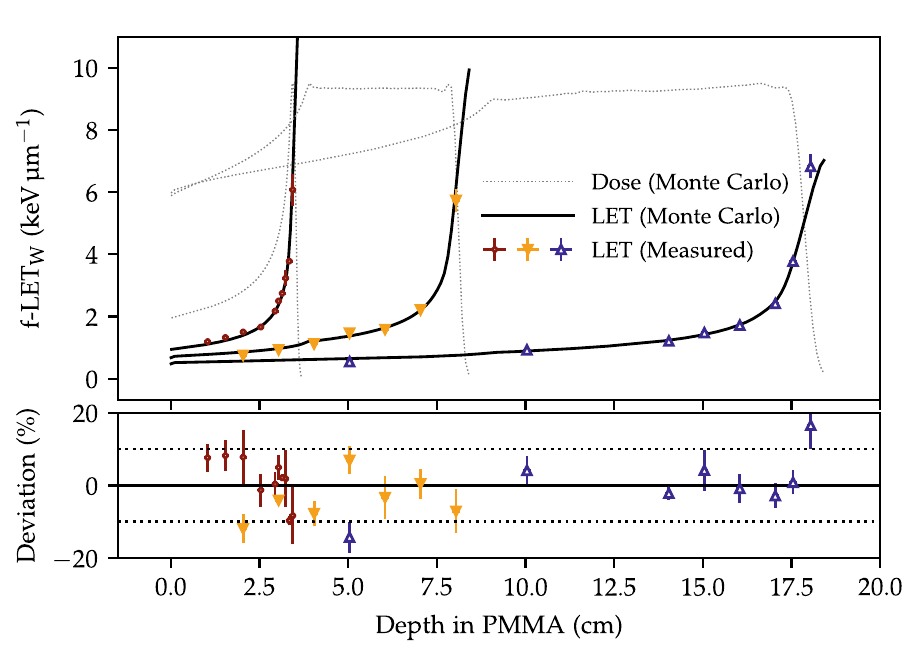
Figure 6. The estimated LET for the three fields f 1 , f 2 , and f 3 using the S / S R LET calibration curve along with the simulated LET (solid lines). The horizontal dashed lines in the lower subfigure denotes the ± 10% deviations from the Monte Carlo simulated LET. The dose profiles are shown for